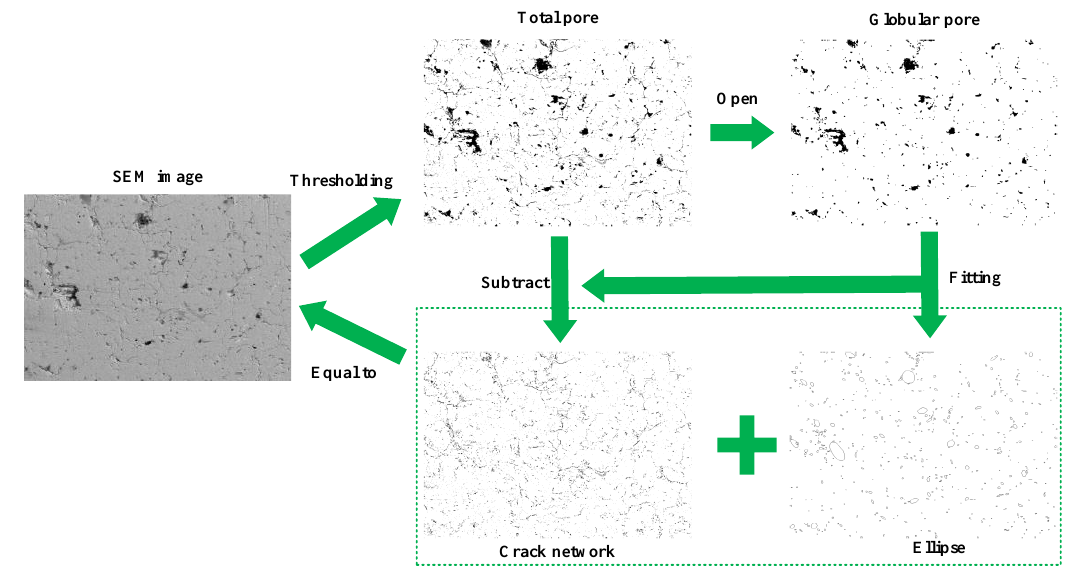
Figure 3. Extraction of microscopic features of thermal barrier